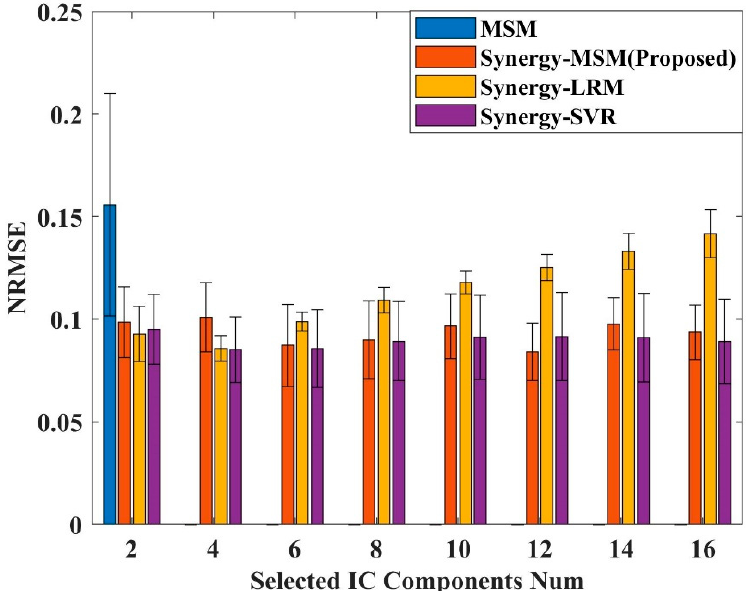
Figure 5. Average NRMSE for prediction using different numbers of IC components for Subject 5. The IC components were selected from the angles measured during joint flexion and extension and the CC values between the IC components. Half the number of IC components are correlated with flexion and the other half are correlated with extension.